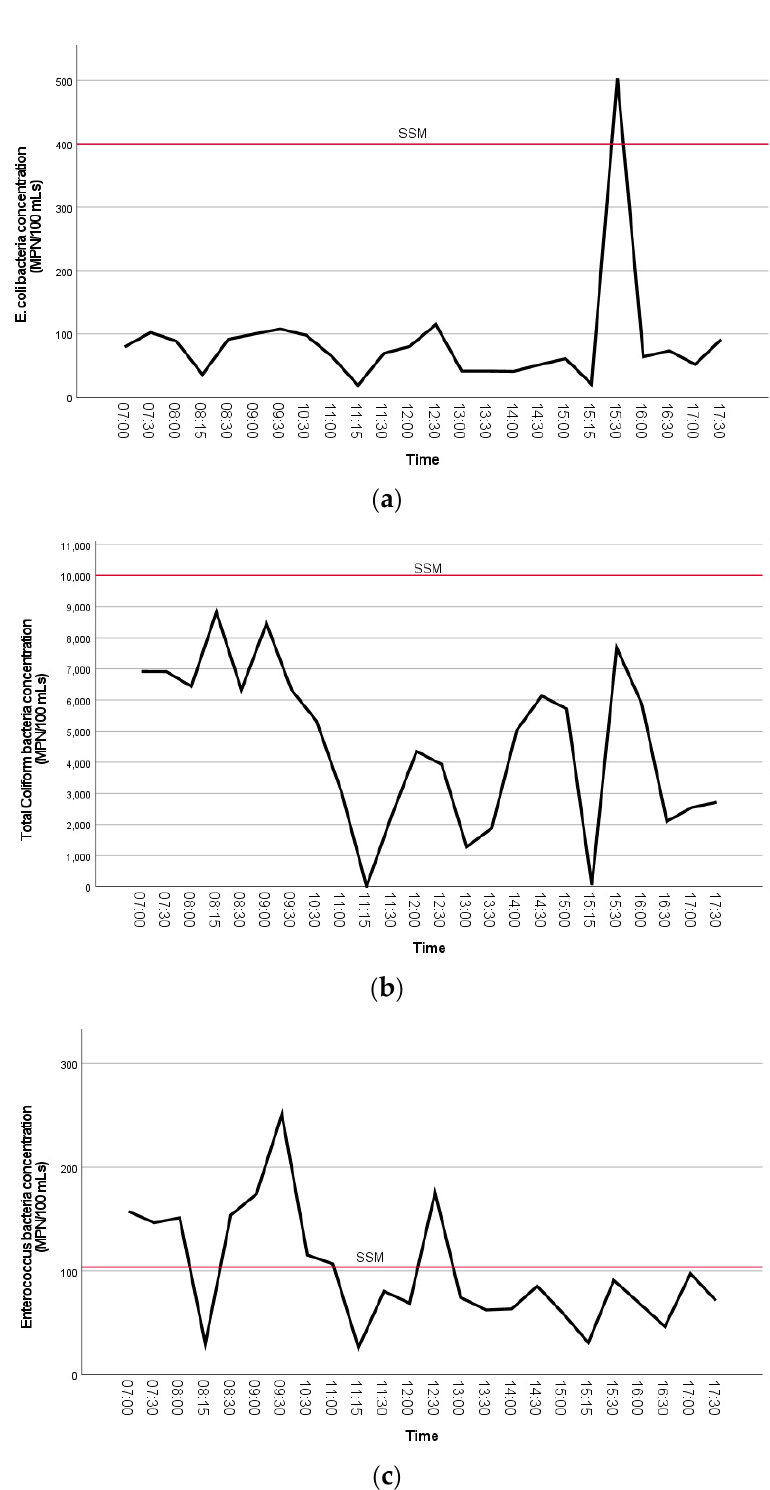
Figure 4. ( a – c ). The mean distributions of FIB bacteria concentrations (MPN/100 mL) ( A . E. coli , B . total coliform, C . enterococci) at Clam Beach near Strawberry Creek (sites 2a and 2b combined) are visually shown in the line plots. The single sample maximum (SSM) threshold is indicated on each plot.